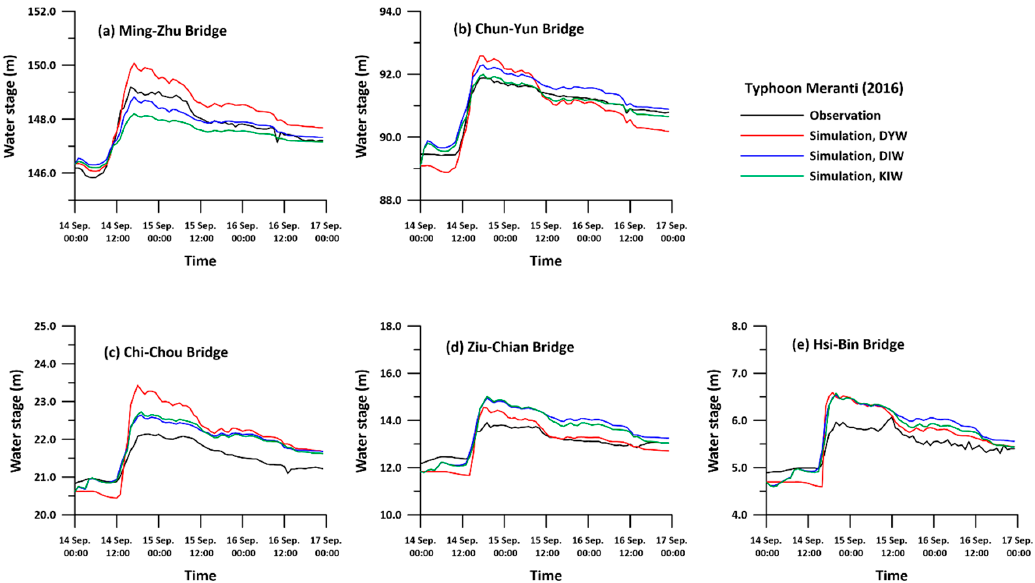
Figure 10. DYW/DIW/KIW simulations of Typhoon Meranti (2016). Water 2018 , 10 , x FOR PEER REVIEW